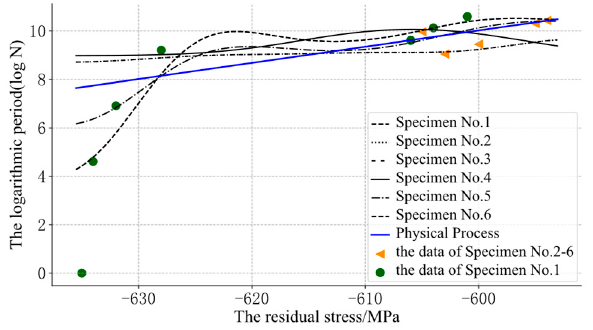
Figure 7. The assessment results of the SVR.